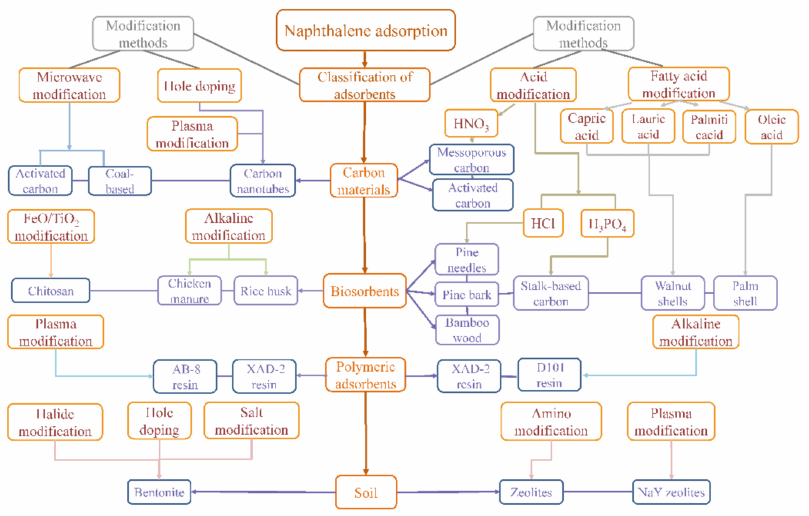
Figure 1. The detailed classification of adsorbents and modification methods of adsorbents commonly used for